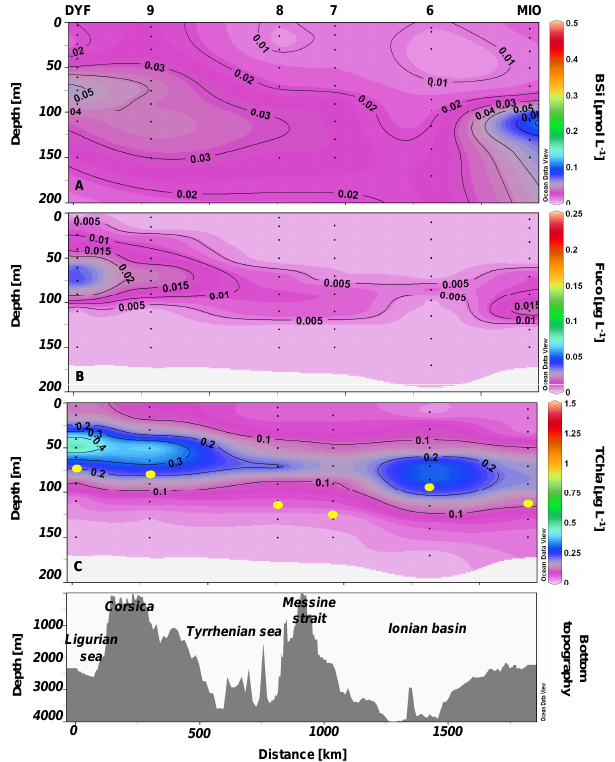
The distribution of particulate organic carbon is presented together with BSi:POC ratios in Figs. 7 and 8. POC distribu- tion revealed a very similar pattern compared to TChl- a with maximum concentrations found in the Alboran Sea at 50 m (7 µmol L − 1 ) , spreading in the Algero-Provencal0 basin at depth, and a new increase in the Ionian basin between sta- tions 5 and MIO, reaching 3 µmol L − 1 . POC was very low below 100 m ( < 1 µmol L − 1 ) except at site 1, where moderate concentrations were measured at 150 m (Fig. 7a). BSi:POC ratios were quite elevated, by comparison to the Brzezinski (1985) ratios, in the Alboran Sea (0.25 at station 2 at 90 m) and over the Sicily Strait (0.19 at station 5 at 120 m; Fig. 7b). A third increase was observed at the MIO station, where BSi:POC ratio reached 0.11 at 130 m. On the second tran- sect, POC distribution was quite monotonous (Fig. 8a), with a small subsurface maximum spreading from the DYF station to the MIO station without much decrease at depth. Surpris- ingly, a subsurface maximum was observed at station 7 be- tween 10 and 50 m (4.6 to 5.5 µmol L − 1 ) which did not match any increase in Chl- a , Fuco or BSi, and could reflect the pres- ence of heterotrophs. BSi:POC ratios were low ( < 0.01) over the entire 0–50 m layer, but increased at depth and in particu- lar at two locations, at station 9 at 150 m (0.10) and at station MIO (0.11) as mentioned above (Fig.